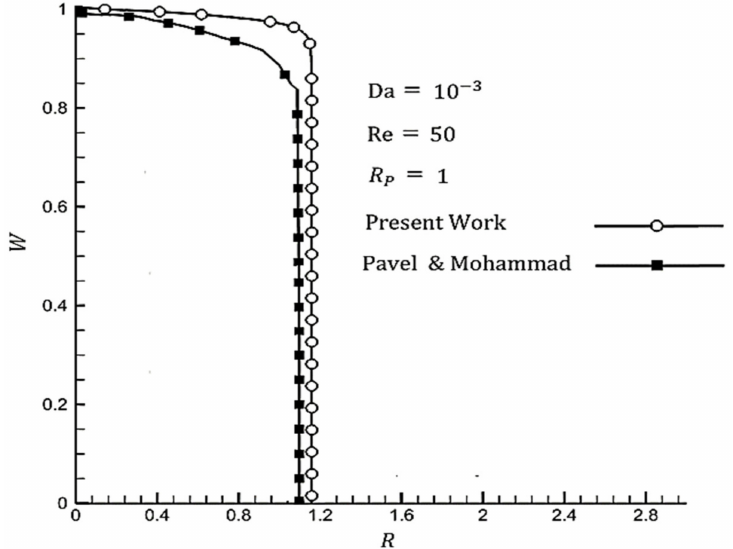
Figure 11. Velocity comparison in fully filled porous medium with